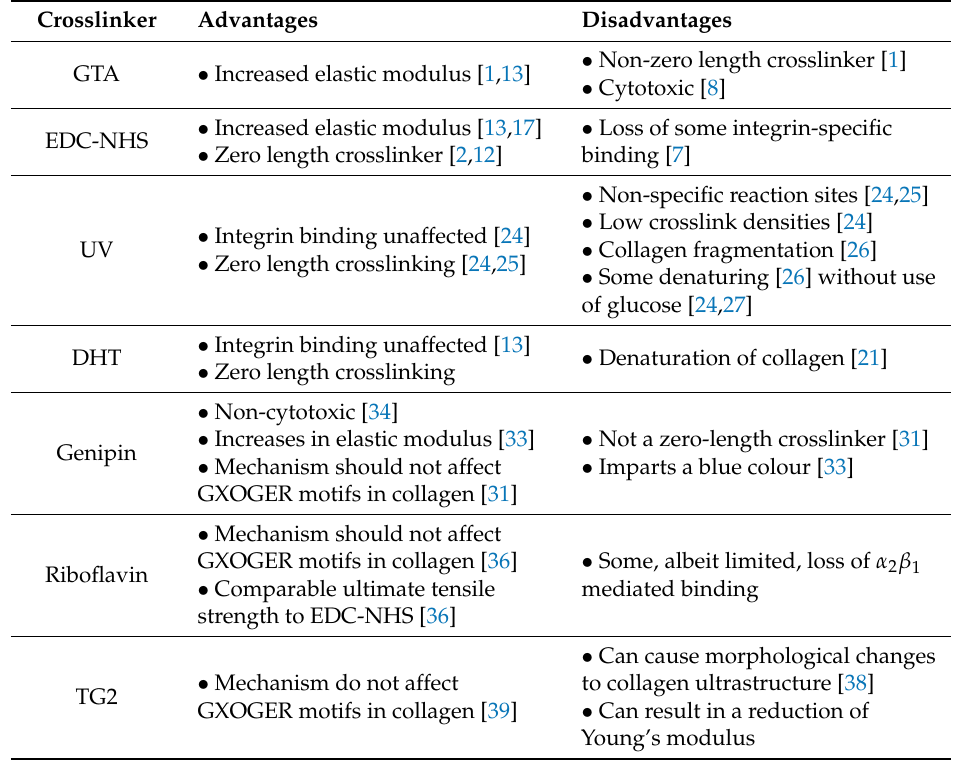
Table 1. Summary of the advantages and disadvantages of current crosslinking systems used in collagen-based